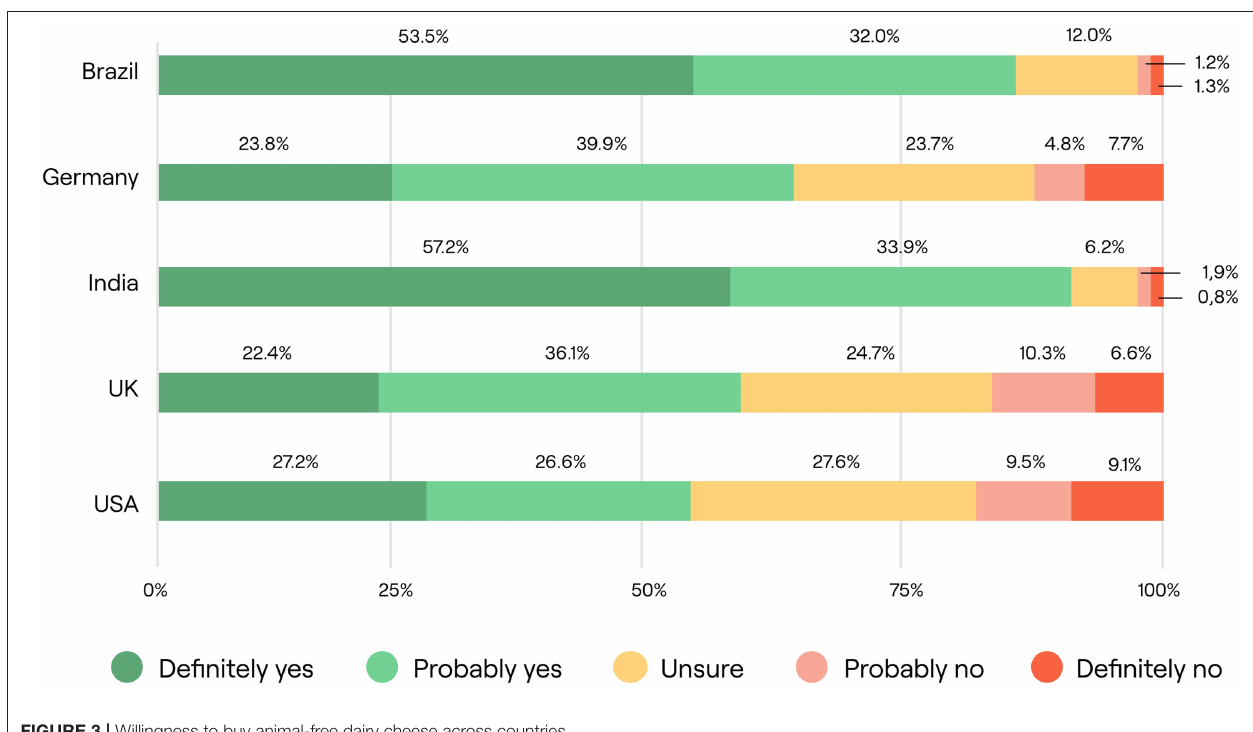
FIGURE 3 | Willingness to buy animal-free dairy cheese across countries.